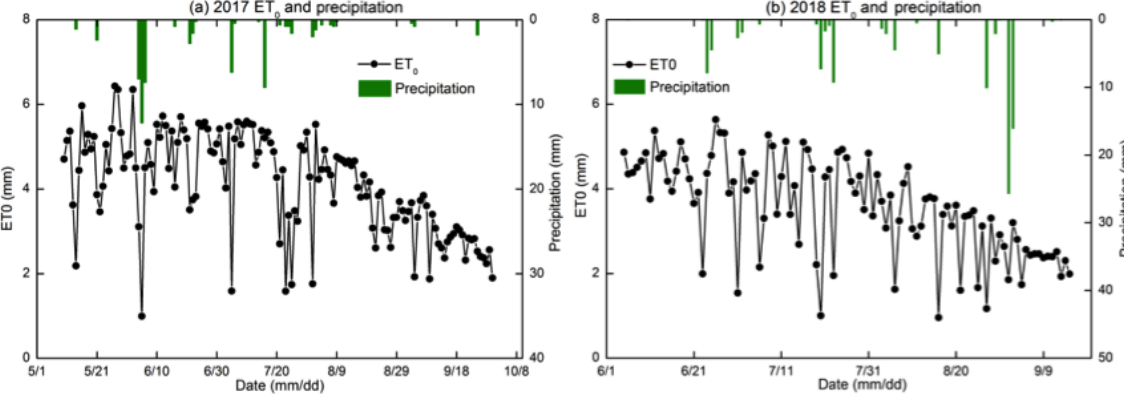
Figure 4. Reference evapotranspiration (ET 0 ) and precipitation during the crop growth period in 2017 and 2018.